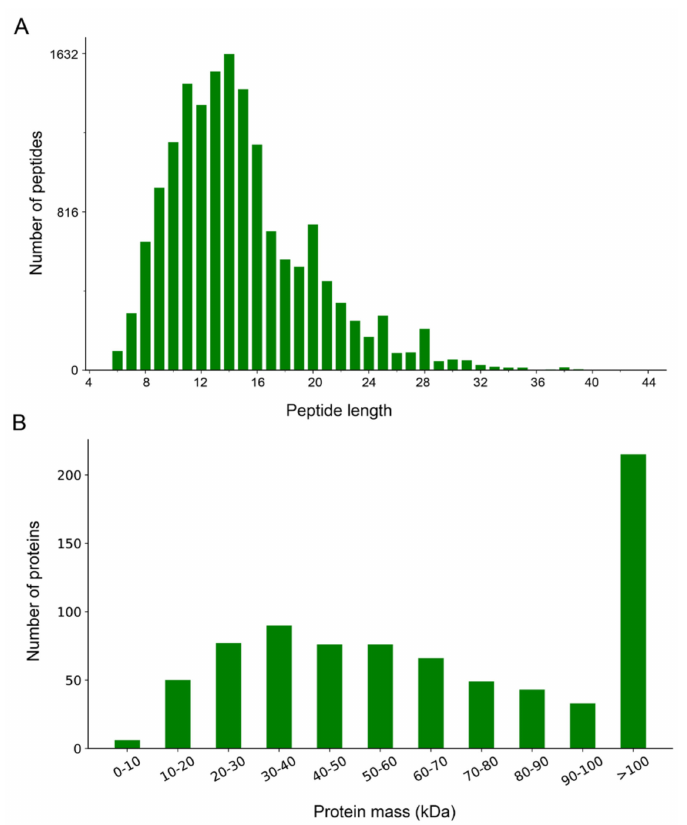
Figure 1. Overview and characterization of proteomes from BF and SOL muscles. ( A ) Distribution of length of the identified peptides. The X–axis represents peptide length, while the Y–axis represents the number of peptides. ( B ) Distribution of molecular weight of the identified proteins. The molecular weight of the proteins is represented by the X–axis, and the number of proteins is presented on the